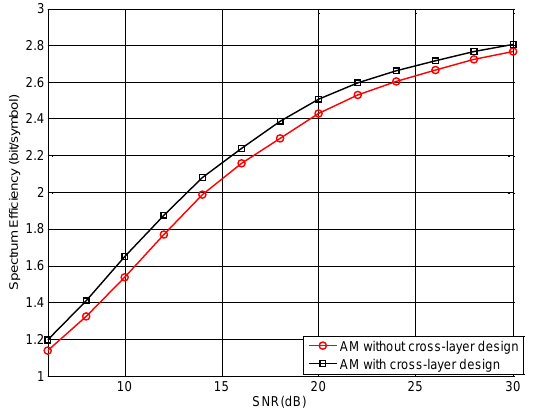
Fig.7 Spectral efficiencies for physical layer network coding system with and without cross-layer